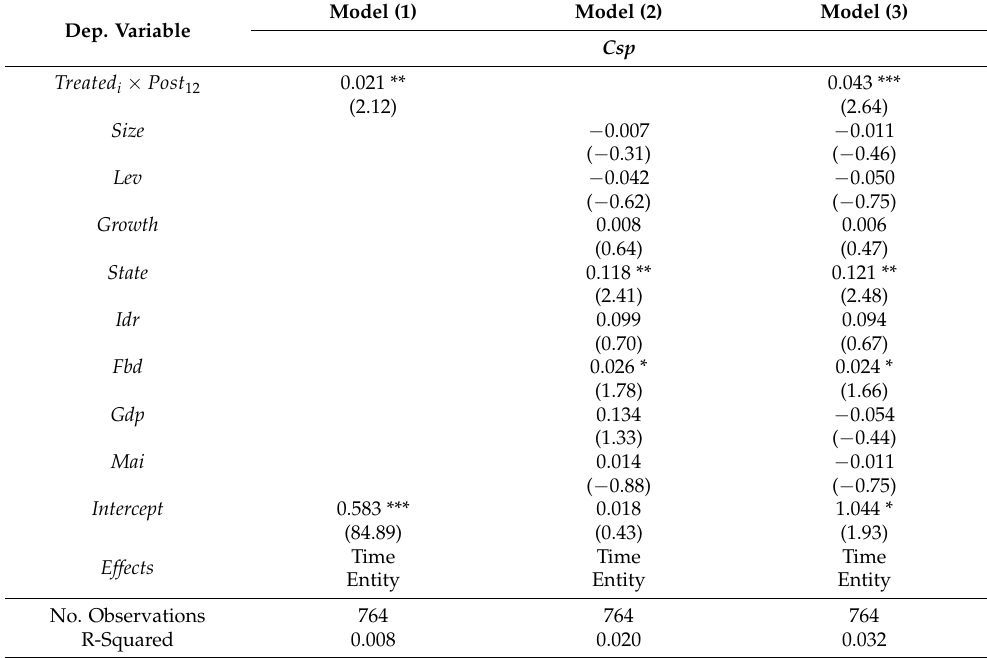
Table 4. Main effects of GCP on